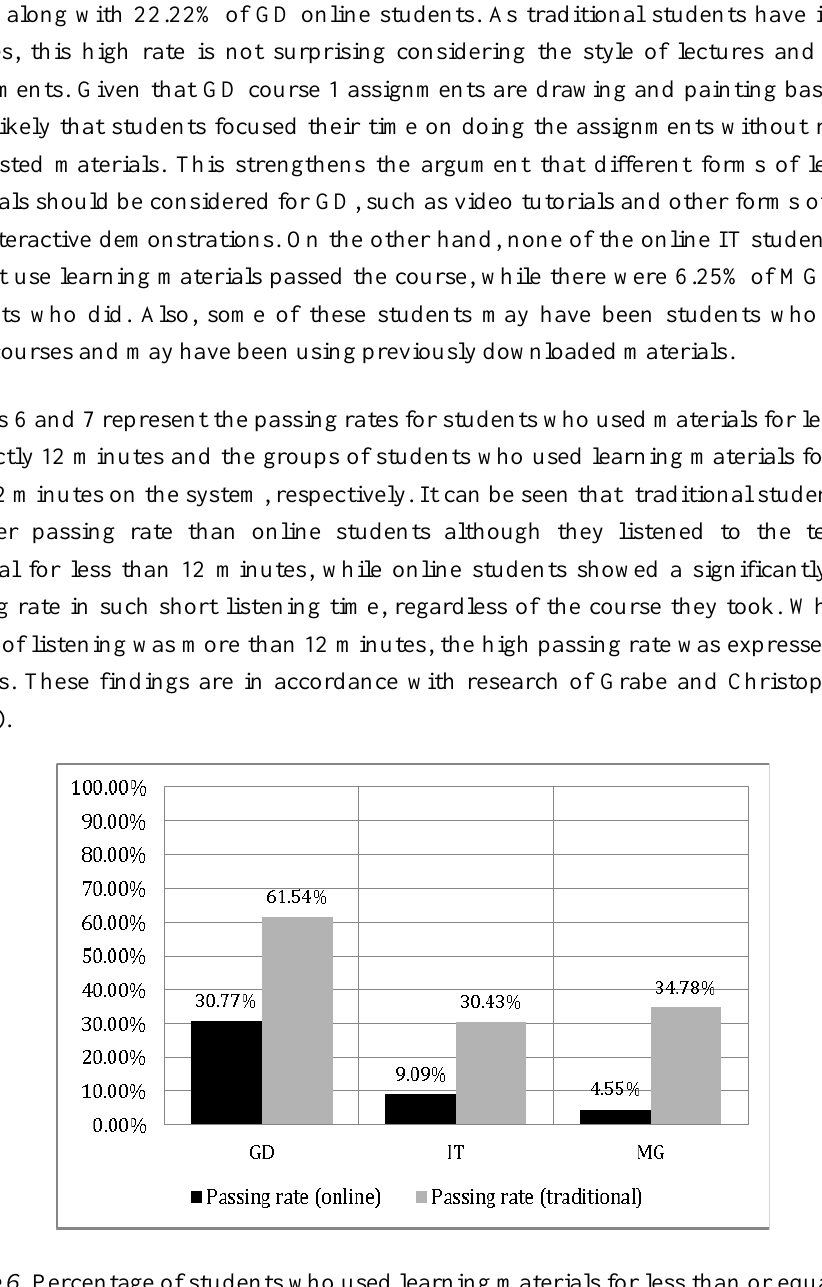
Figure 6 . Percentage of students who used learning materials for less than or equal to 12 minutes and who passed the GD, IT, and MG